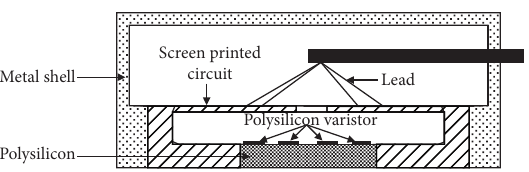
Figure 3: Packaging schematic diagram of miniature silicon pie- zoresistive Earth pressure